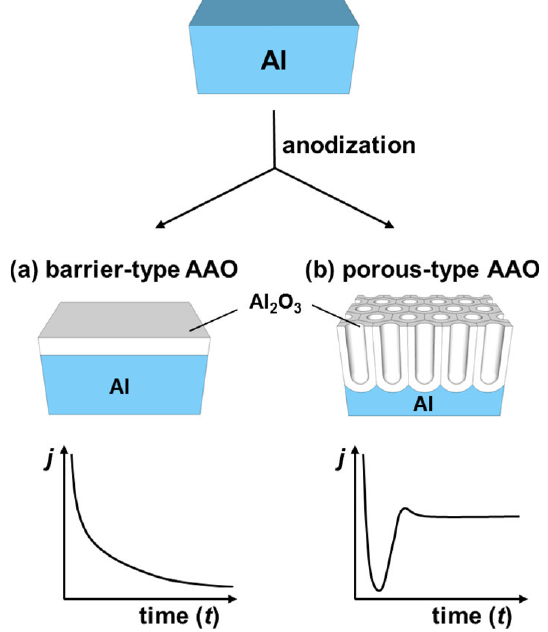
Figure 3. Two sorts of anodic alumina films ( a ) barrier-type and ( b ) porous-type with their respective anodization current curves as time evolves under potentiostatic conditions. The two types of anodic alumina are reprinted with permission from Ref. [30]. Copyright 2014 American Chemical Society.